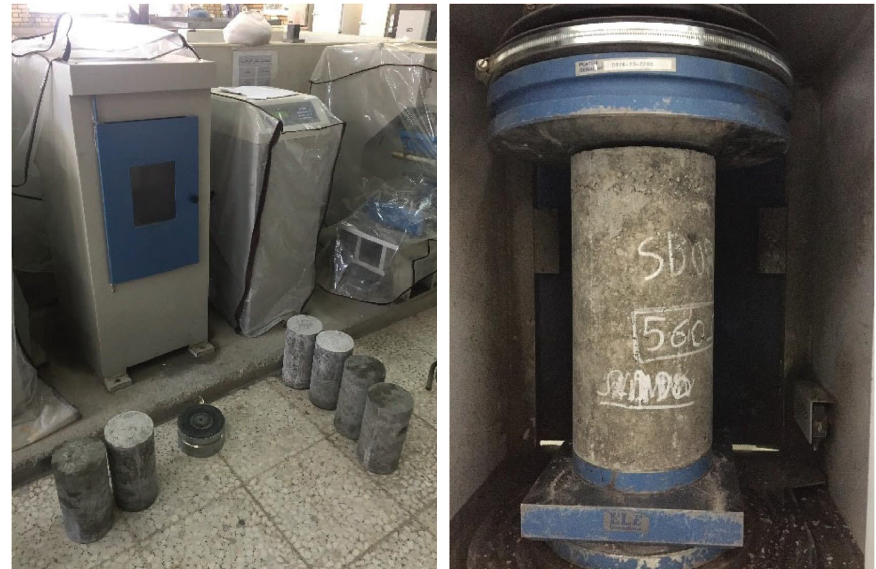
Figure 4: Compressive strength test.